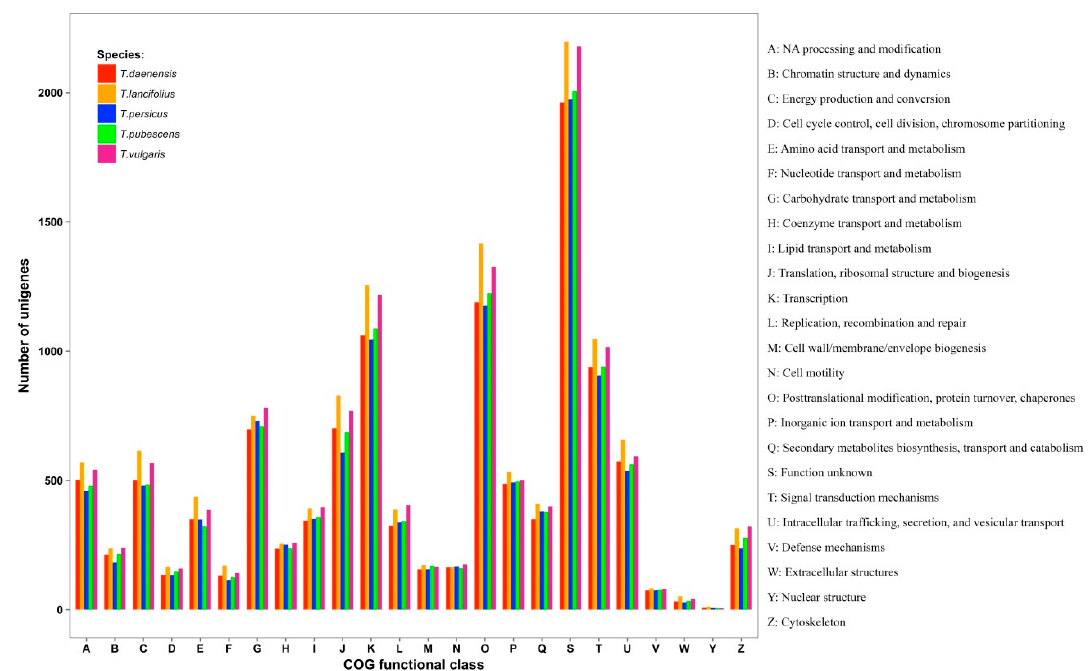
Figure 3. COG classification map. The abscissa represents 24 COG group names, while the vertical axis represents the number of unigenes annotated into each group.